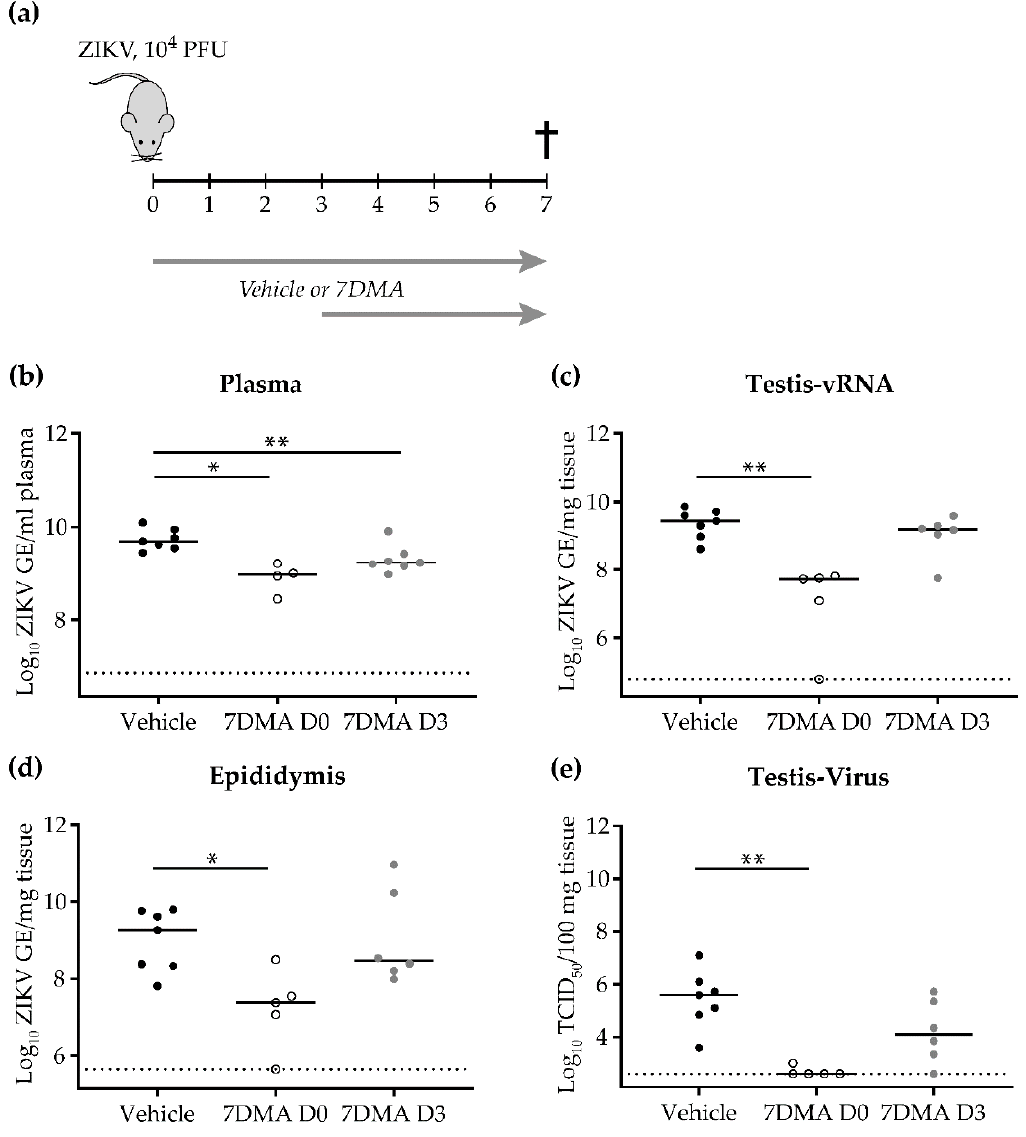
Figure 3. Early 7DMA treatment is required to e ffi ciently inhibit ZIKV replication in male reproductive organs. ( a ) Schematic representation of the study design. Male AG129 mice (6-10 weeks of age) were inoculated intraperitoneally with 10 4 PFU of ZIKV. The inhibitory e ff ect of 7DMA on ZIKV replication in plasma ( b ), the testis ( c , e ), and the epididymis ( d ) at day 7 pi is compared between vehicle-treated mice (black, n = 7) and mice treated with 7DMA starting either at the day of infection (white, n = 5) or at day 3 pi (grey, n = 7). Data are presented as medians and statistical analysis was performed using the Mann-Whitney U test, * = p < 0.05, ** = p ≤ 0.006 (Graphpad software). GE; genome equivalents. The dotted line represents the limit of detection.